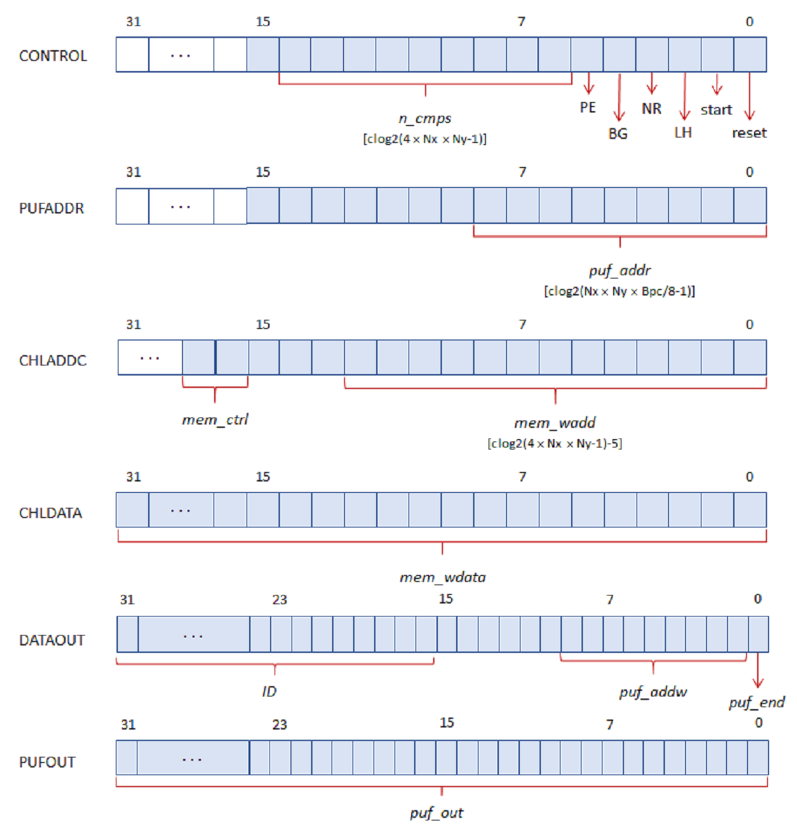
Figure 6. Input and output IP module